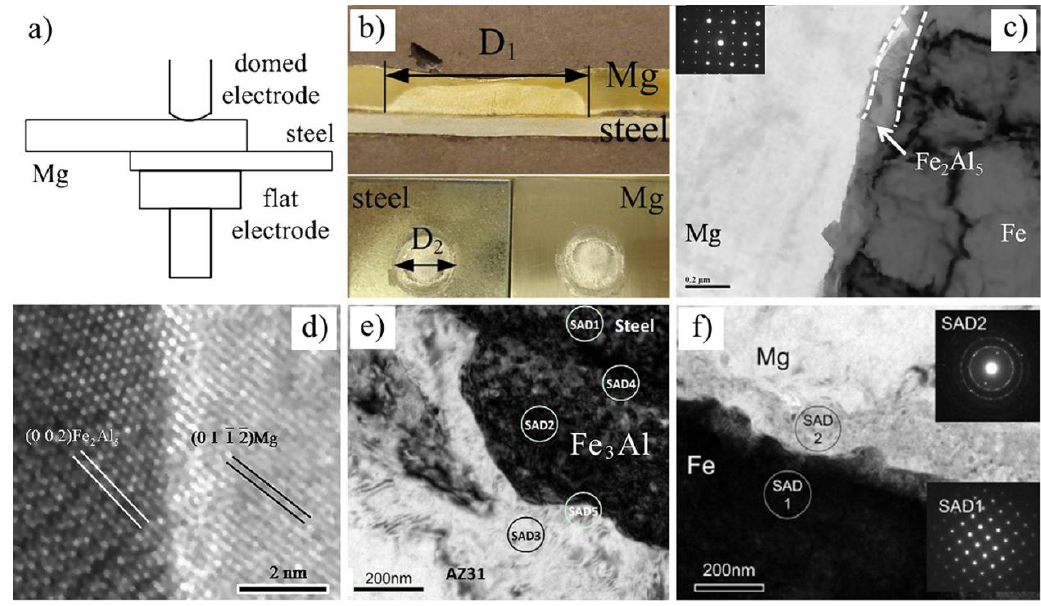
Figure 24. Mg/steel RSW process [87,89,90] ( a ) schematic diagram; ( b ) cross section of weld and fracture surface; ( c ) Mg/Fe 2 Al 5 /Fe interface structure; ( d ) HRTEM of Fe 2 Al 5 and Mg; ( e ) bright field image of the interface IMC layer of AZ31/DP600 steel joint; ( f ) high magnification image of the Mg/IF steel interface.